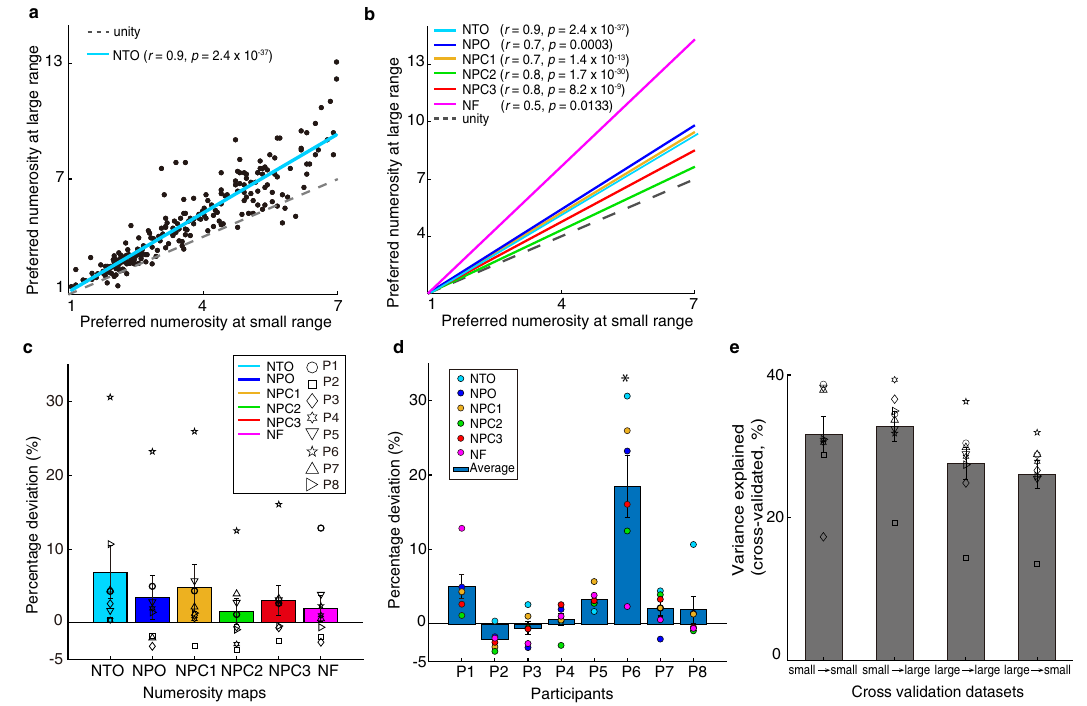
Fig. 2 Relationship between numerosity preferences estimated from small and large ranges indicates similar numerosity selectivity and topographic progressions. a Participant 1 ’ s NTO (see the maps in Fig. 1a & b) numerosity preferences estimated from the two ranges were strongly correlated (see legend of the Pearson correlation coef fi cients and statistical signi fi cance). Dots show the estimates from individual recording sites (variance explained >30%), the blue line shows the linear fi t between the two estimates, the dashed line shows unity (i.e., identical preferences). b Linear fi ts from all six of this participant ’ s maps. These also re fl ect strong correlations in each map (see legends), indicating a similar spatial organization of estimated numerosity preferences, and are consistently above the unity line. c Bars show averaged percentage deviation quantifying the difference between the slopes of the linear fi ts (in ( b )) and the unity line for each map. Error bars show the standard errors of the mean over participants ( n = 8). A two-sided Wilcoxon signed rank test shows the percentage deviation of all these maps were above zero ( z = 3.4, p = 0.0006, df = 47), suggesting a slight increase of preferred numerosity estimates at the large range. d Bars show averaged percentage deviation (same as in ( c )) for each participant. Error bars show the standard errors of the mean ( n = 6). Post hoc analysis shows signi fi cant difference between participant 6 and other participants (Bonferroni corrected for multiple comparions; * indicates p = 3.0 × 10 − 8 ). e Bars represent averaged cross-validated variance explained of the within- and cross-condition cross validation datasets. Error bars indicate standard errors of the mean over participants ( n = 8). Within-subject two way ANOVA analysis shows no signi fi cant differences between the cross validation datasets ( p > 0.025, two-sided, Bonferroni corrected for multiple comparisons). Source data are provided as a source data fi